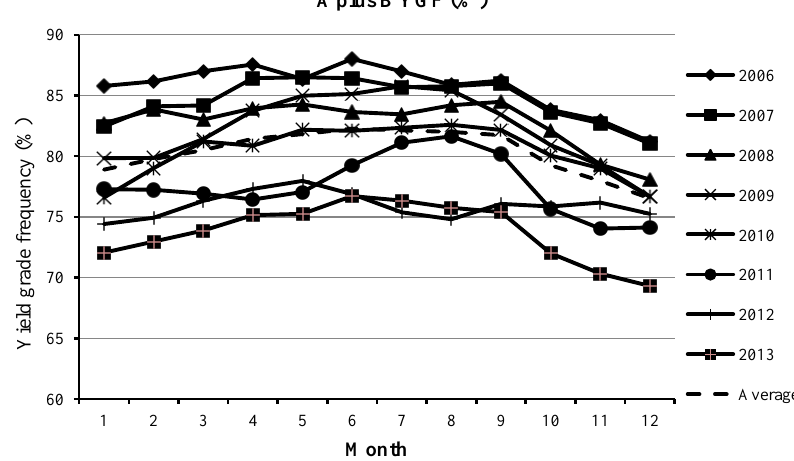
Figure 2. Monthly comparison of A+B yield grade frequency (YGF) in Korean cattle steers for 8